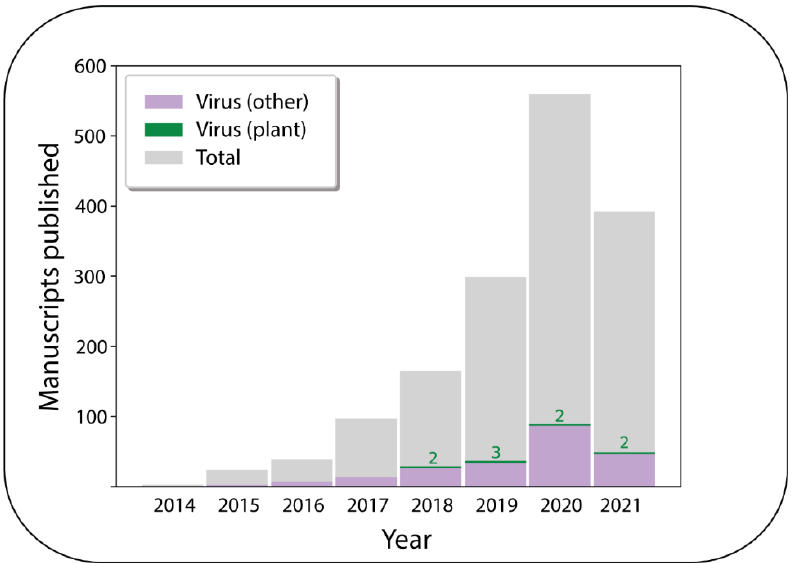
Figure 1. A histogram showing the number of peer-reviewed publications each year relating to Ox- ford Nanopore Technologies’ MinION platform as registered in the National Center for Biotechnology Information Pubmed database. The numbers in green represent the number of these publications that studied plant viruses. The database search was performed on the 10th of June 2021 using the keywords “nanopore”, “nanopore sequencing”, and “nanopore minion”. After manual curation of the results for unrelated manuscripts and review/perspective articles, a total of 3896 publications were identified.